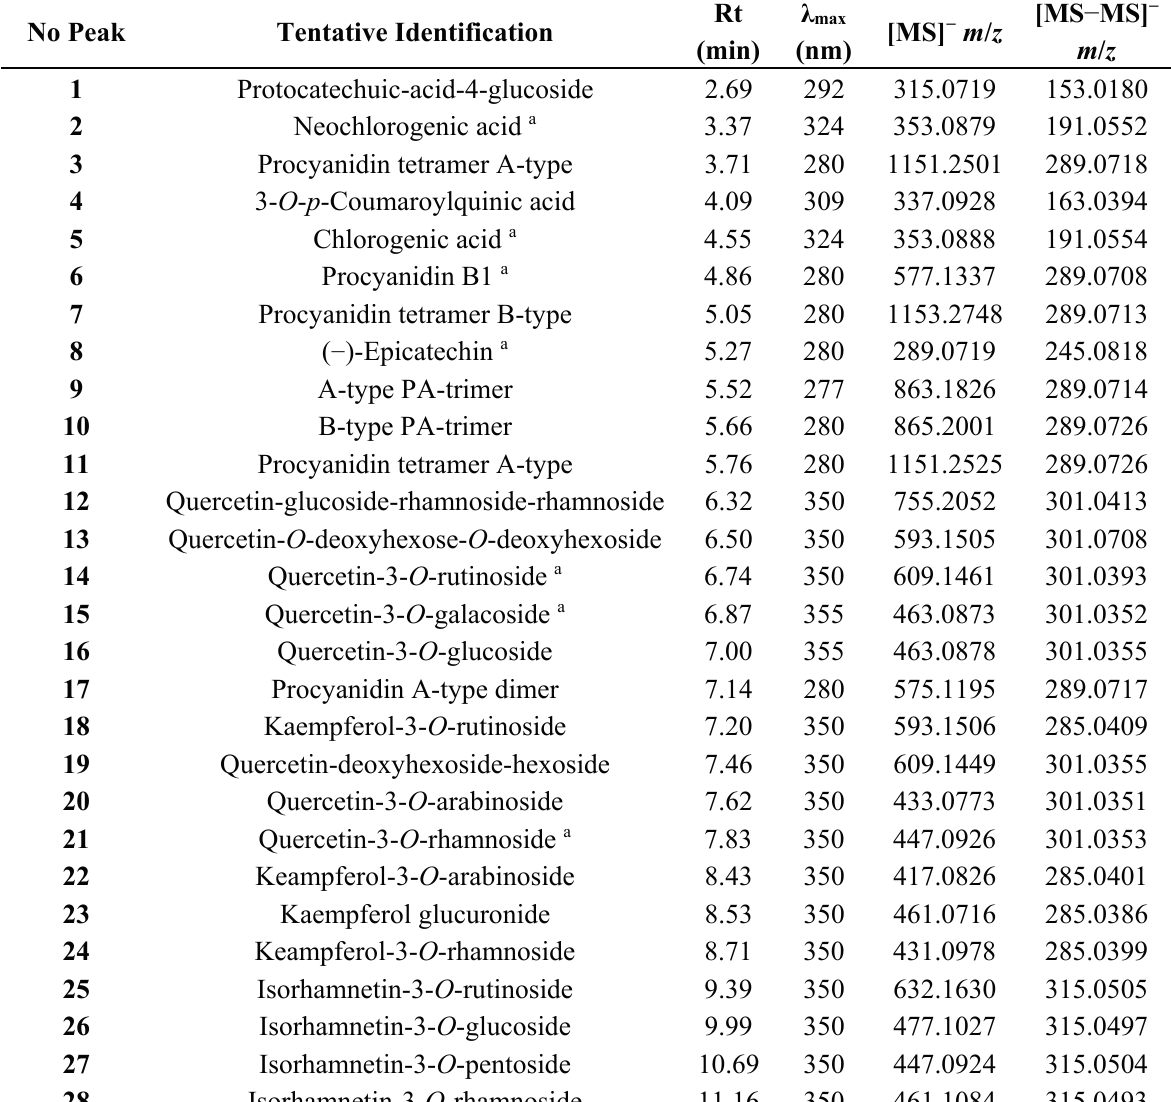
Table 1. The characterization of phenolic compounds of the Aesculus leaves using their spectral characteristic in UPLC-DAD (retention time, λ max ) and negative ions in